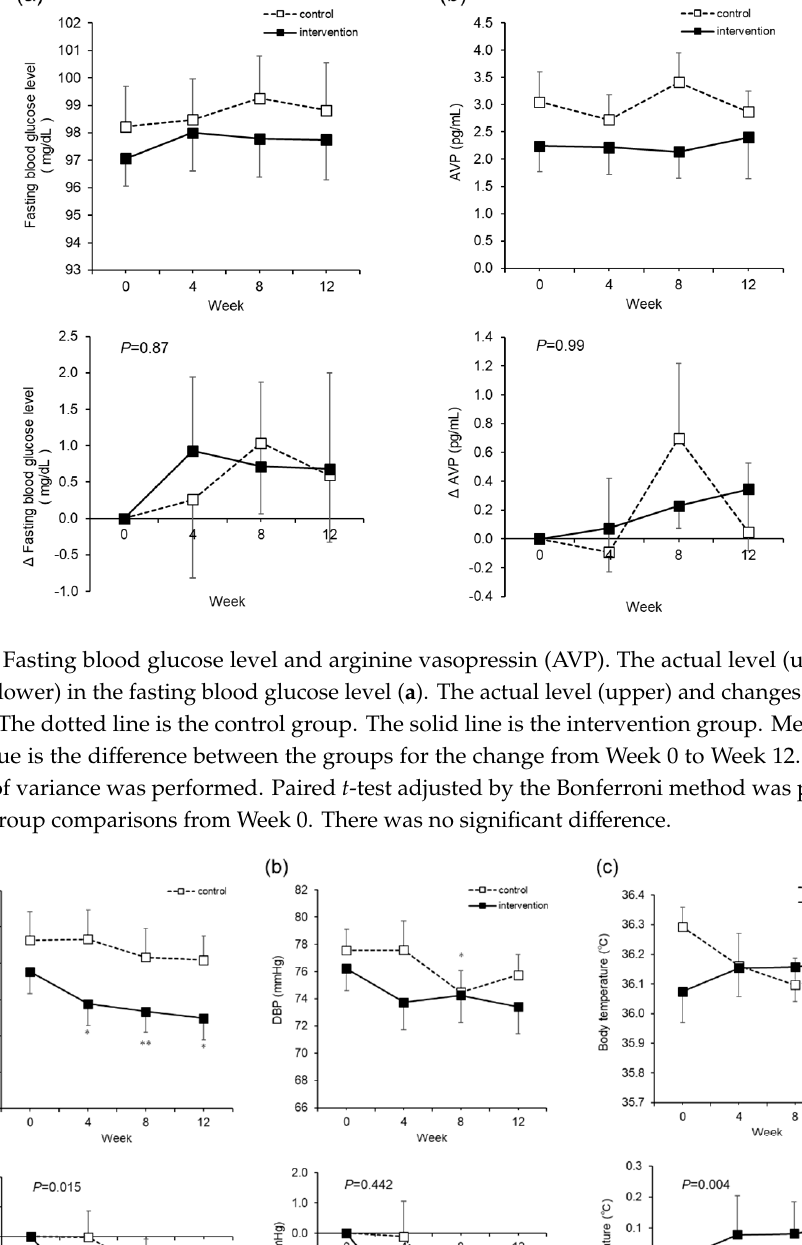
9 of 17 Figure 3. Total body water (TBW) rate and extra-cellular water (ECW)/TBW. The actual level (upper) and changes (lower) in the TBW rates ( a ). The actual level (upper) and changes (lower) in ECW/TBW ( b ). The dotted line is the control group. The solid line is the intervention group. Mean ± SEM. The P value is the difference between the groups for the change from Week 0 to Week 12. Two-way analysis of variance was performed. * Paired t -test adjusted by the Bonferroni method was performed for intragroup comparisons from Week 0. * p < 0.05, ** p < 0.001. 3.3. Effects of Increased Water Intake